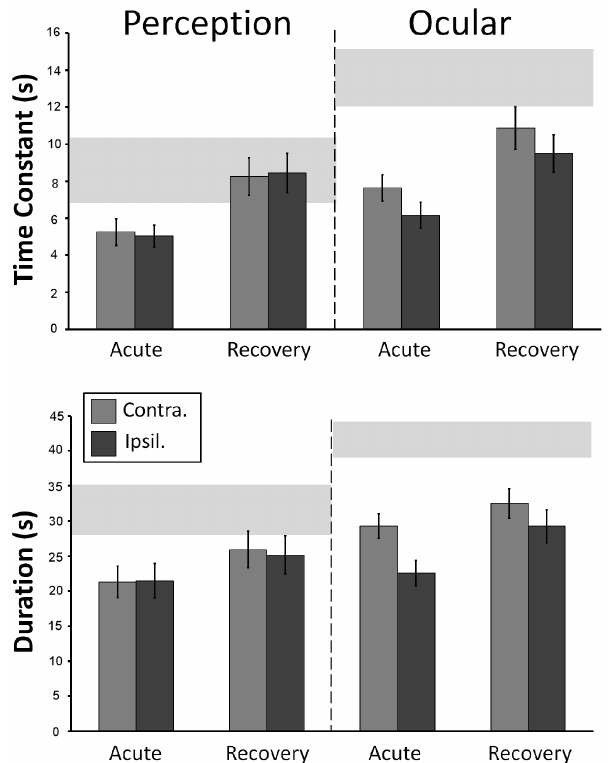
Figure 5. Time constant and duration VO and VP supra- threshold responses at acute and recovery stages. Mean ( 6 SE) supra-threshold duration and time constants for perception (right panel) and vestibulo-ocular (left panel) responses in VN patients, acutely and at recovery. Grey horizontal bars show normative data (95% confidence interval for mean).